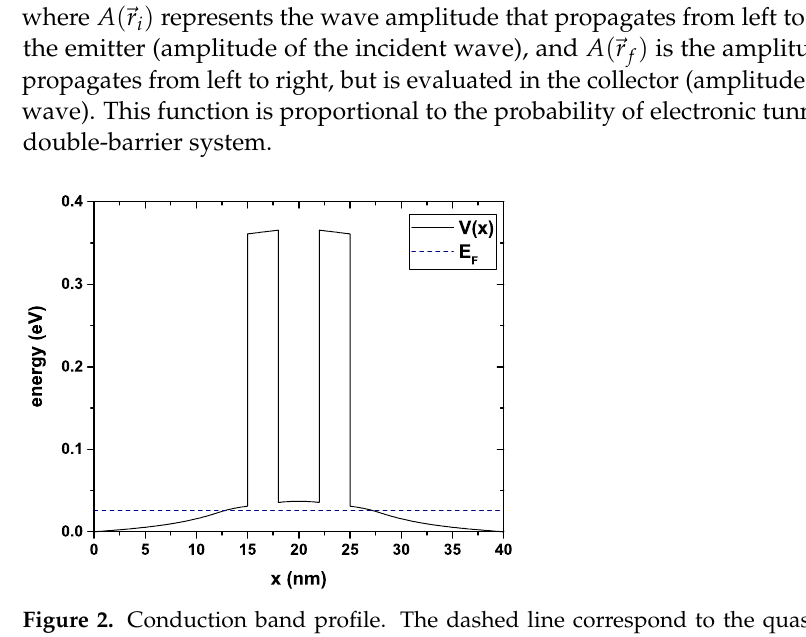
Figure 2. Conduction band profile. The dashed line correspond to the quasi-Fermi Level. The calculations are for L w = 4nm, L b = 3nm, L s = 3nm, L d = 12nm and n d = 1.2 × 10 18 cm − 3